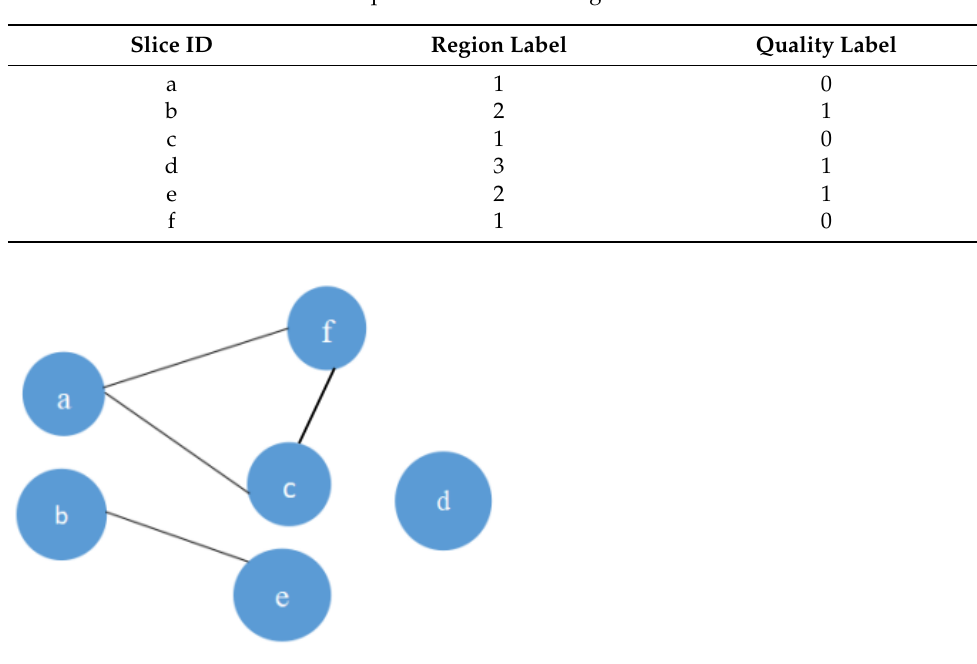
Table 1. Head CT Slices of different qualities in different regions.